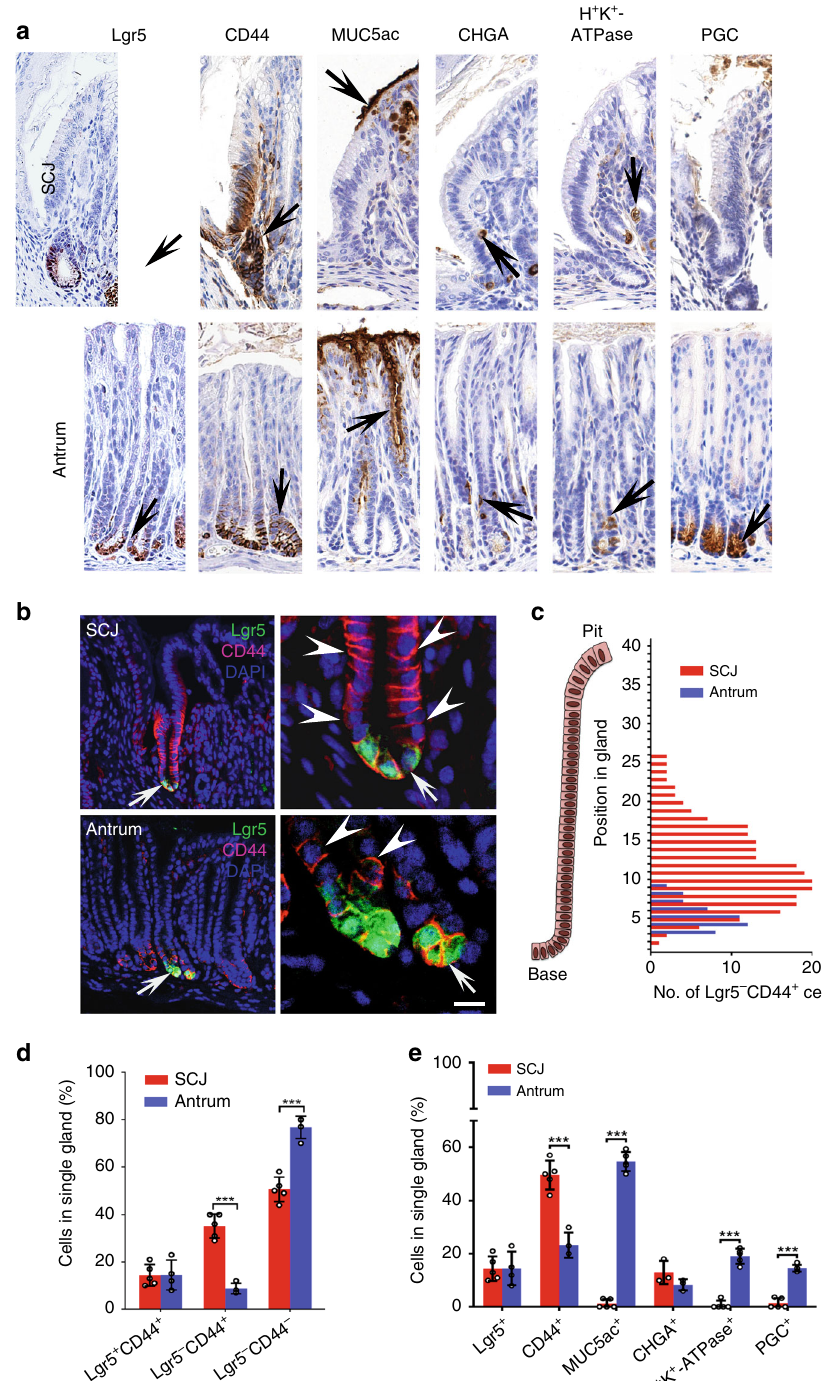
Fig. 2 Comparison of cellular components between gastric SCJ and antrum. a Detection (brown color, arrows) of cells expressing Lgr5 (Lgr5-eGFP), CD44, and differentiation markers of pit cells (Mucin5AC), neuroendocrine cells (chromogranin A, CHGA), parietal cells (H + K + -ATPase), and chief cells (pepsinogen C, PGC). b Detection of Lgr5-eGFP (green) and CD44 (magenta) in the SCJ and antral epithelium. Arrows in left column images indicate areas shown in right column. Arrows and arrowheads in right column images indicate expression of Lgr5-eGFP and CD44, respectively. c Number of Lgr5 − CD44 + cells located at speci fi c positions in glands of SCJ and antrum ( n = 20 in each group). d Quantitative analysis of Lgr5 + CD44 + , Lgr5 − CD44 + , Lgr5 − CD44 − , and OPN + cells at SCJ and antrum ( n = 20 in each group). e Quanti fi cation of cells expressing Lgr5 (Lgr5-eGFP), CD44, and differentiation markers ( n = 3 or more in each group). Elite ABC method ( a ) and immuno fl uorescence ( b ). Counterstaining with hematoxylin ( a ) and DAPI ( b ). Scale bar in b represents 40 μ m ( a ), 50 μ m (left panels of b ), 15 μ m (upper right panel of b ), and 10 μ m (lower right panel of b ). ** P < 0.01, *** P < 0.001, two-tailed unpaired t -tests. All error bars denote s.d. Source data are provided as a Source Data fi